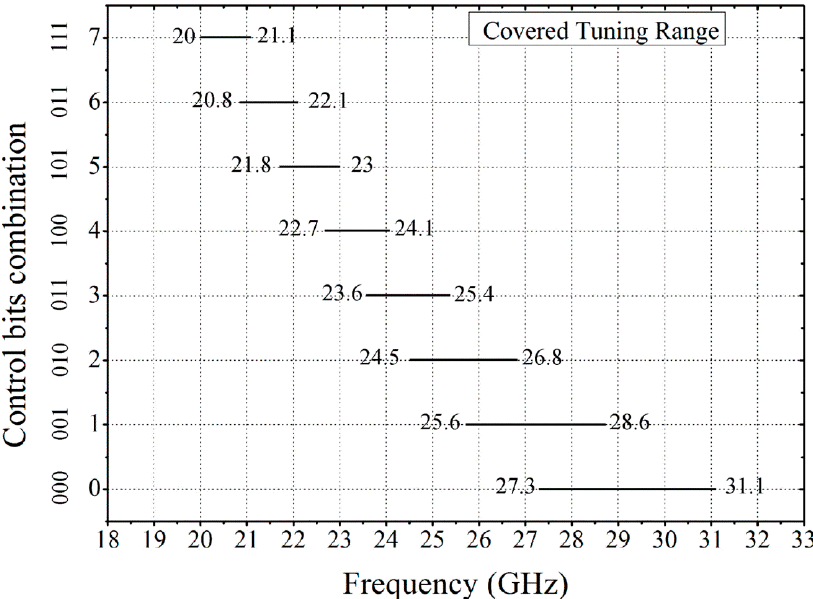
Figure 8. Voltage Controlled Oscillator (VCO) output frequency as a function of the capacitor bank control word.